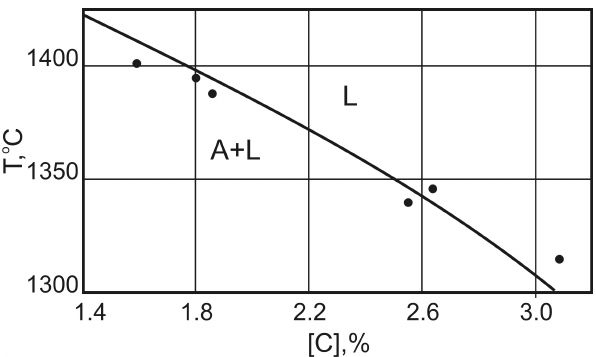
Figure 4. Line liquidus section of Fe-C diagram with